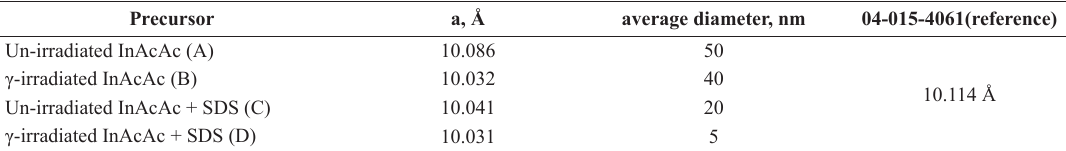
Table 2. Some of experimentally calculated parameters for the as-synthesized nanoparticles.